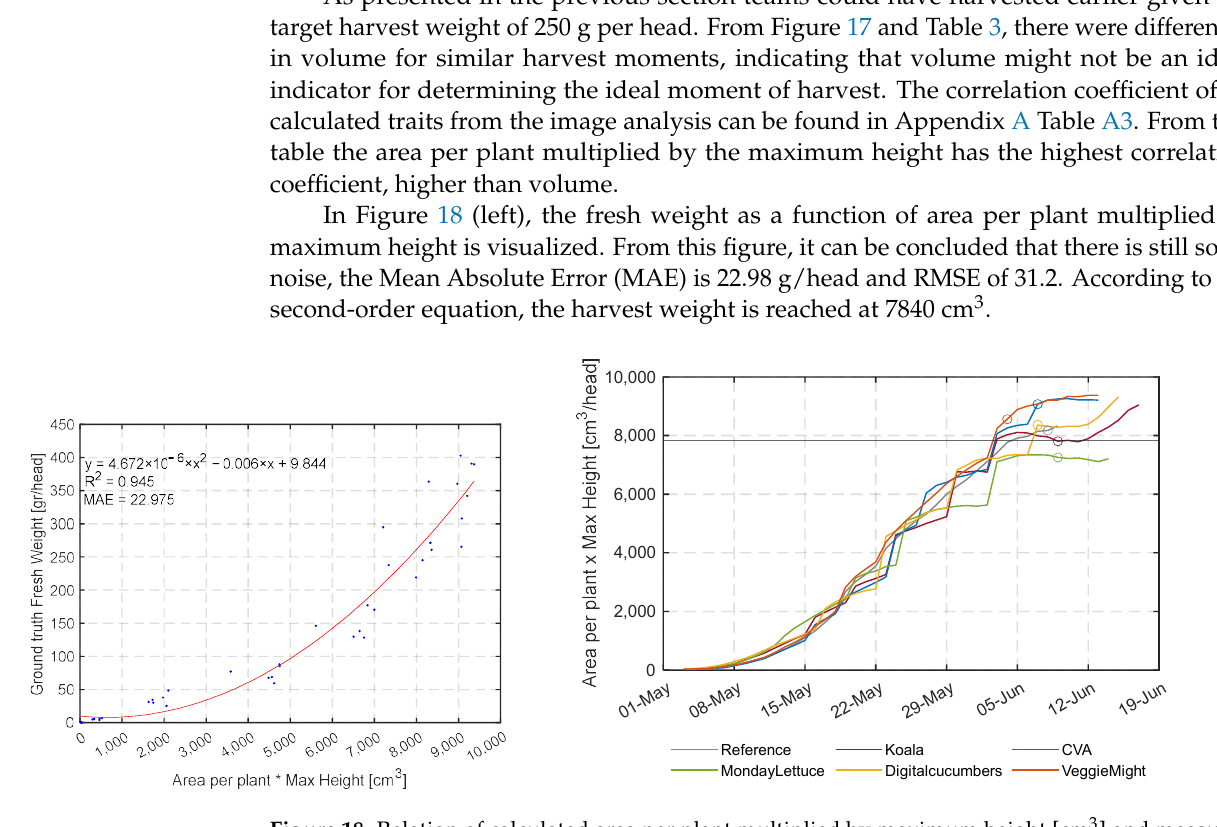
Figure 18. Relation of calculated area per plant multiplied by maximum height [cm 3 ] and measured fresh weight [g/head] ( left ). Area per plant multiplied by maximum height [cm 3 /head] as a harvest indicator in realizing the target weight of 250 g/head in all compartments (dots) ( right ). Table 4. Overview of area per plant multiplied by max height criterion at optimal harvest date (when harvest indicator is 7840 cm 3 per lettuce head is reached).